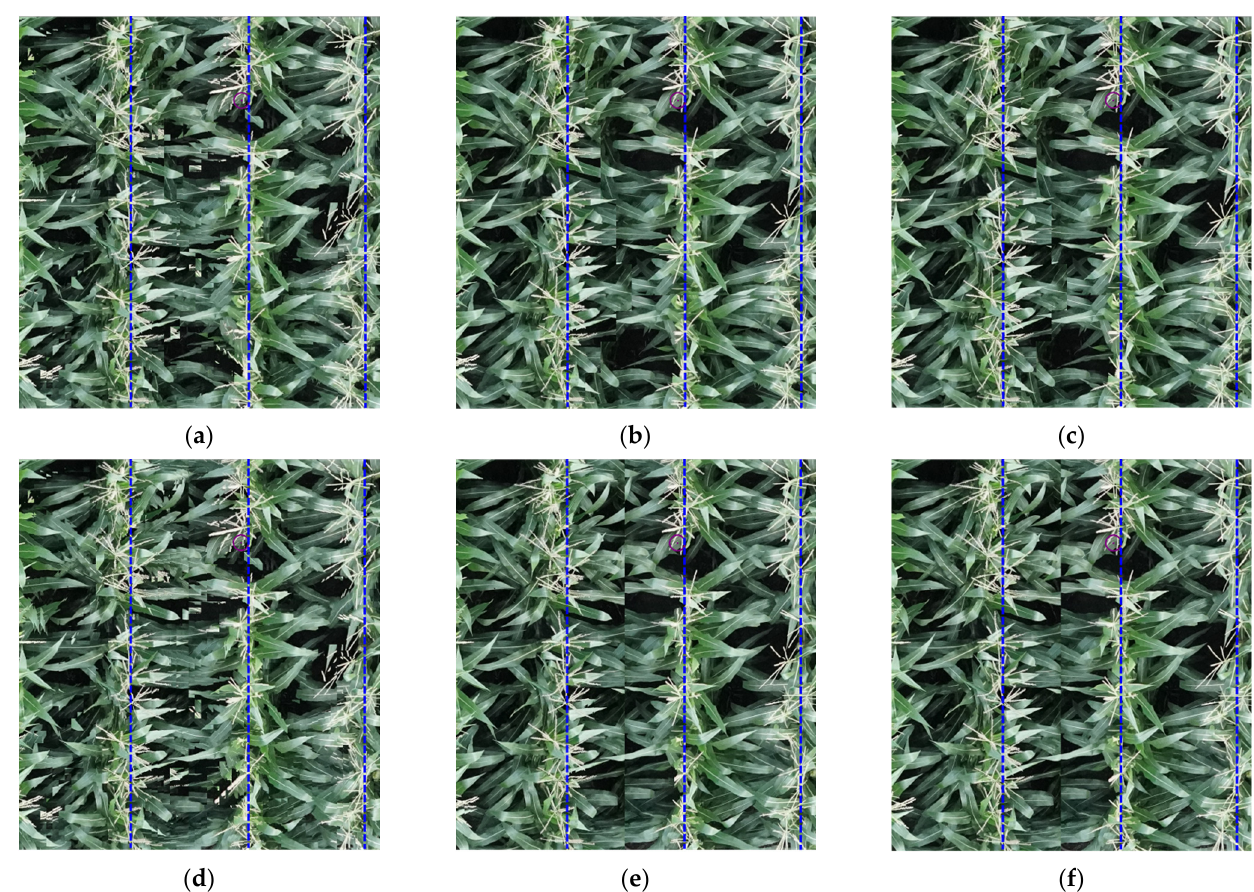
Figure 16. Detected row centerlines (blue dashed lines) superimposed on ( a ) orthophoto i, ( b ) orthophoto ii, ( c ) orthophoto iii, ( d ) orthophoto iv, ( e ) orthophoto v, and ( f ) orthophoto vi. Table 3. Number of SIFT-based matches between the original frame camera images and generated orthophotos using different DSM smoothing and seamline control strategies for 10 row segments. The largest number of established matches for each row segment is in